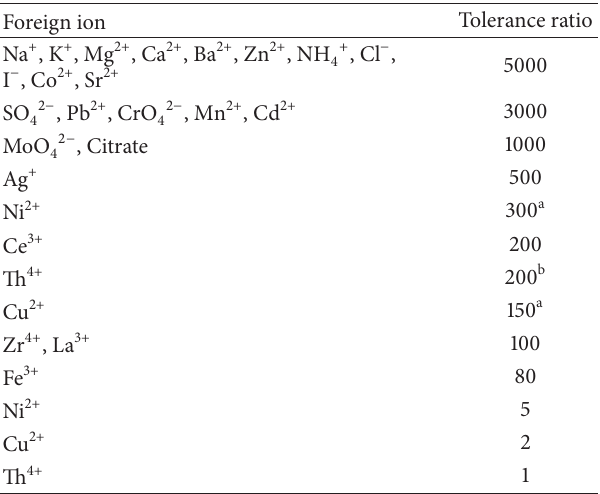
Table 3: Effect of foreign ions on the determination of 7.0 𝜇 g of U(VI) in 1,500-mL aliquots of the